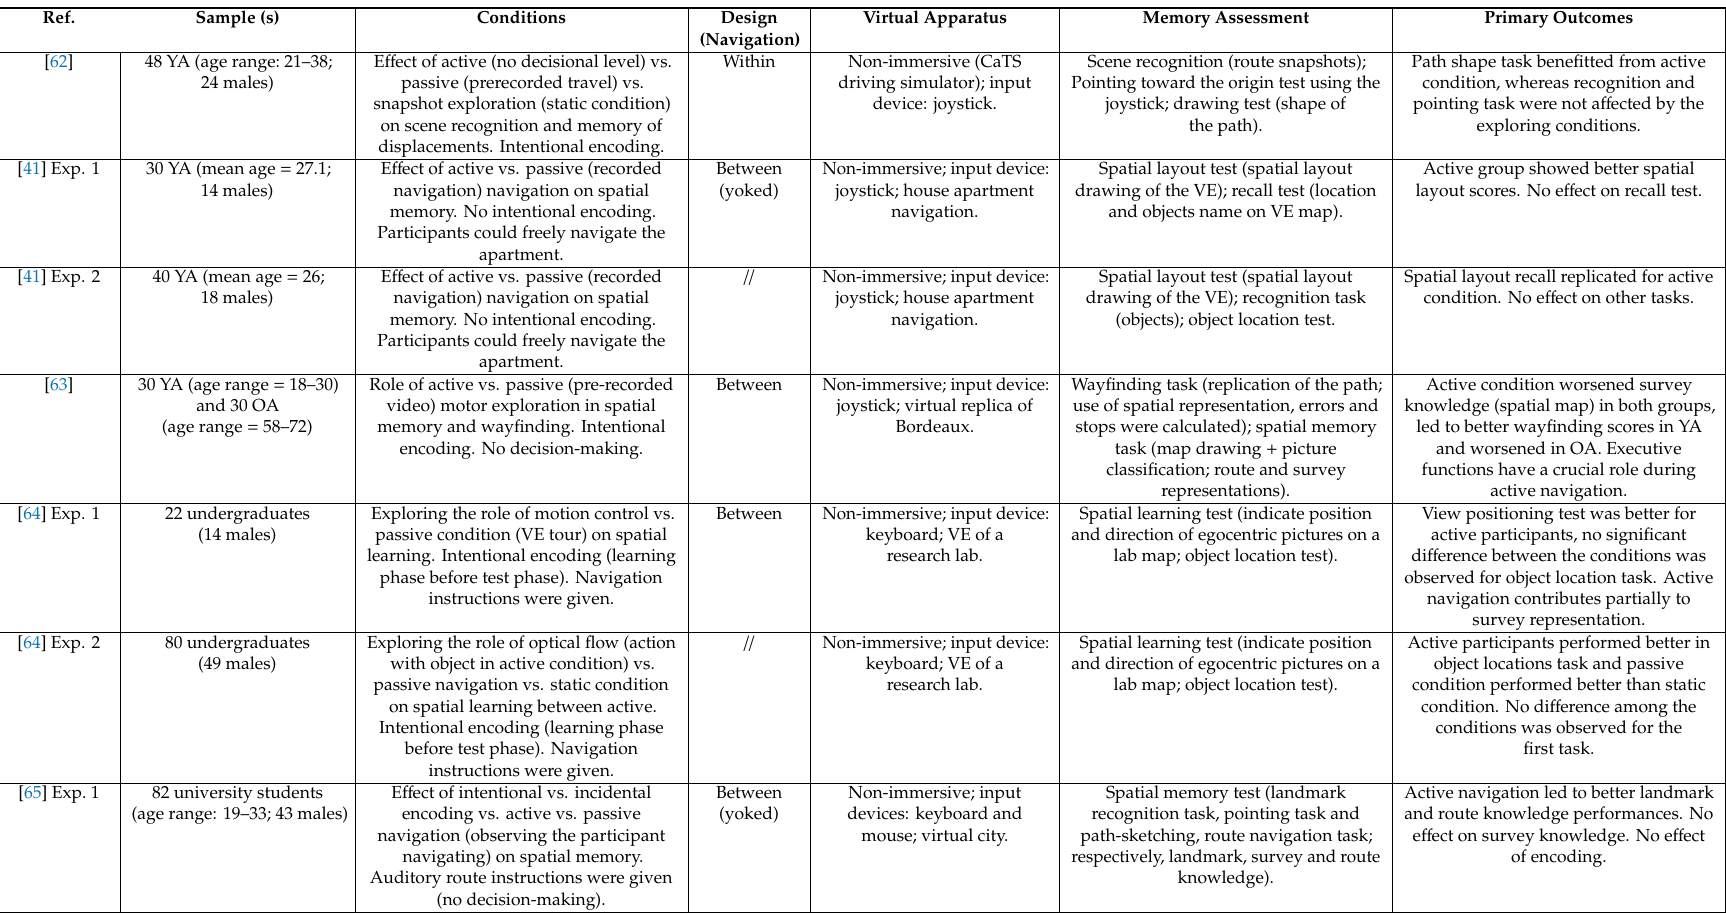
Table 1. Summary of the included studies. VE: virtual environment; HMD: head-mounted display; VR: virtual reality; OA: older adults; YA: young adults; aMCI: amnestic mild cognitive impairment; AD: Alzheimer’s disease; HNC: high navigation control; LNC: low navigation control; IC: itinerary control; Exp.: experiment; // : same as above; 1A: first trial apartment; 2A: second trial apartment; B: third trial